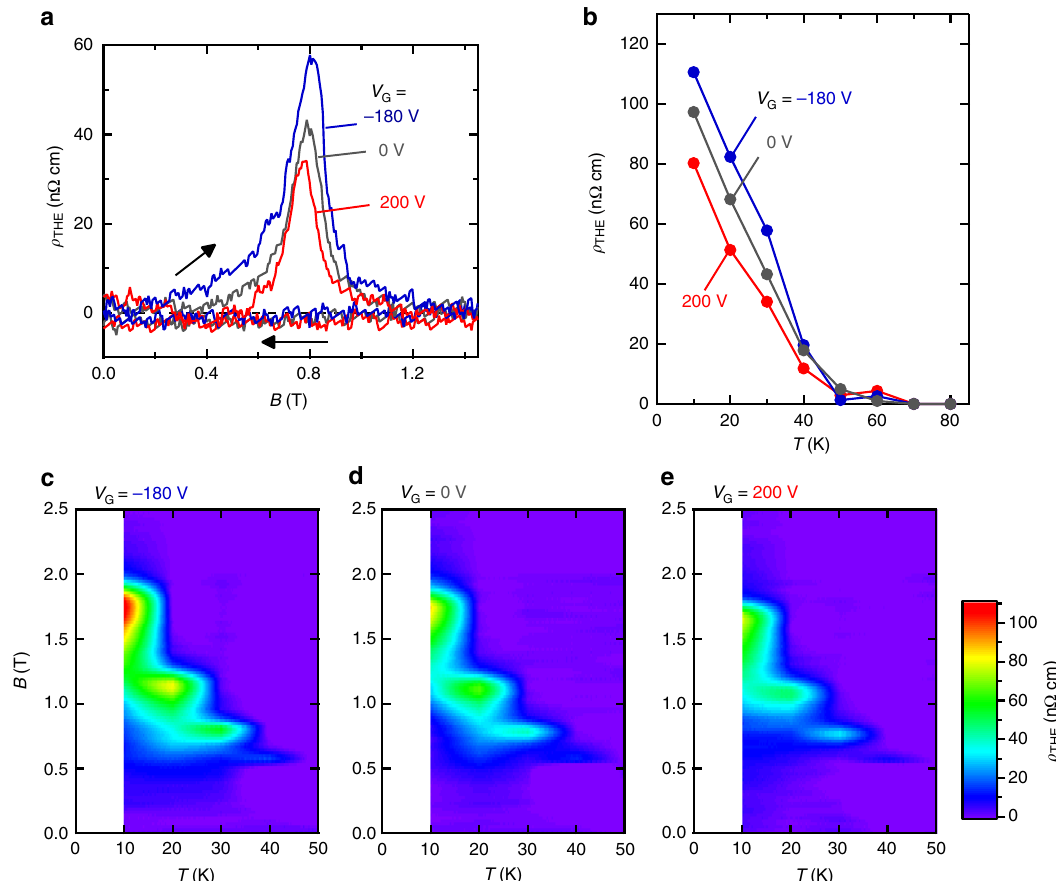
Fig. 3 Electric- fi eld control of topological Hall effect. a Topological Hall resistivity ( ρ THE ) at 30 K as a function of external magnetic fi eld ( B ) under V G = − 180 V (blue line), 0 V (gray line) and 200 V (red line) for SRO5/SIO2/Sub. Black arrows indicate the sweep direction of B . b Temperature ( T ) dependence of ρ THE under gate bias. Color map of ρ THE in the T - B plane under V G = − 180 V ( c ), 0 V ( d ) and 200 V ( e